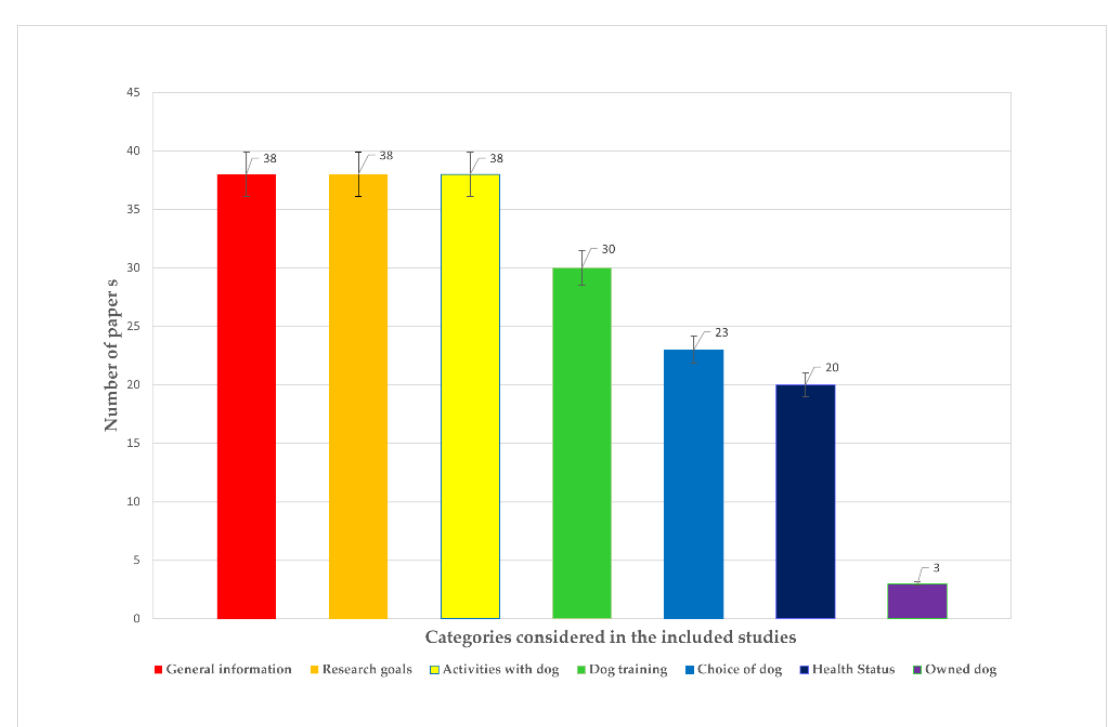
Figure 2. Overview of the results.